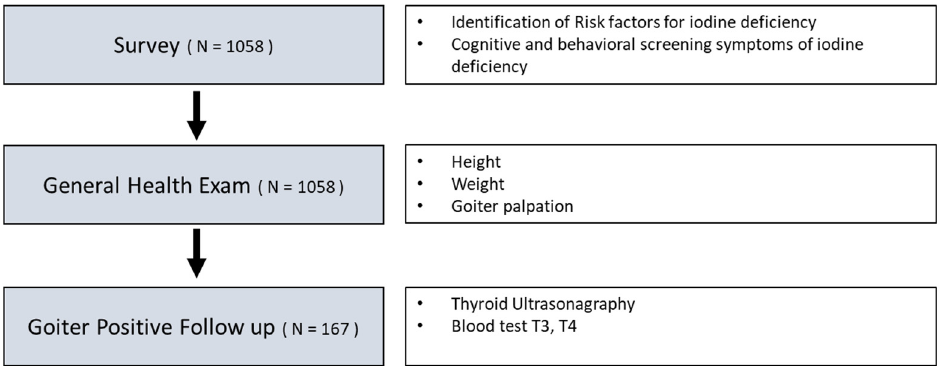
Figure 1. Research Figure 1. Research flow.